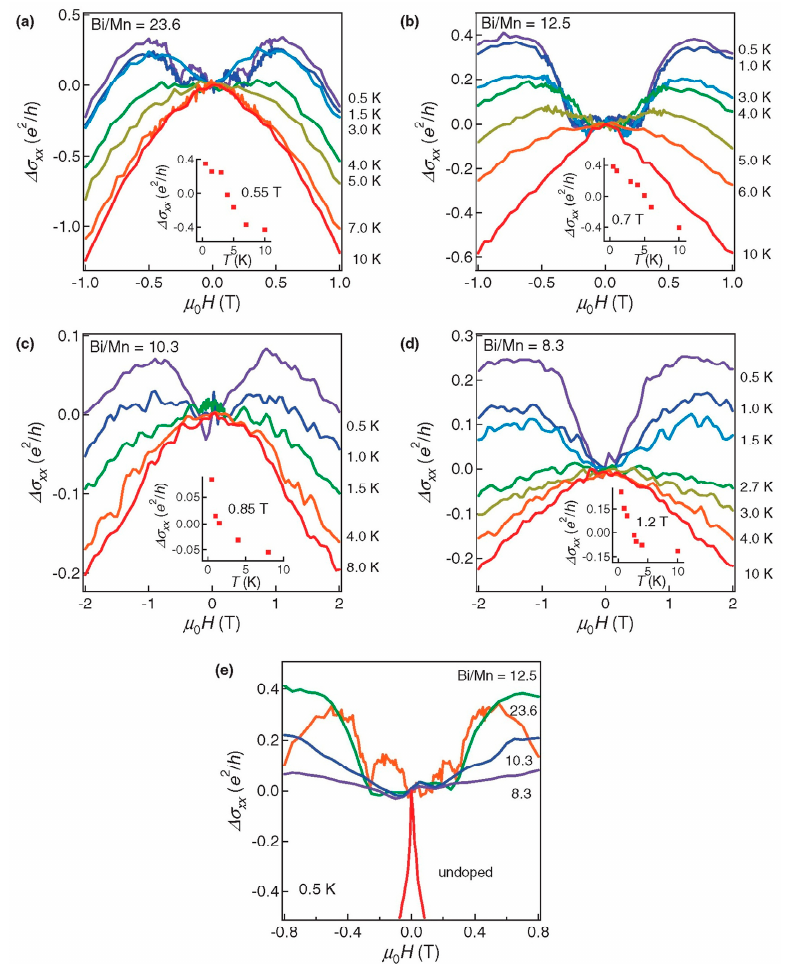
Figure 9. (Color online) MC of Mn-Bi 2 Se 3 in field perpendicular to the sample plane: ( a ) MC of the most lightly doped sample (Bi/Mn = 23.6); ( b ) MC of the Bi/Mn = 12.5 sample; ( c ) MC of the Bi/Mn = 10.3 sample; ( d ) MC of the most highly doped sample (Bi/Mn = 8.3); ( e ) MC of four Mn-Bi 2 Se 3 and one undoped Bi 2 Se 3 sample [126].